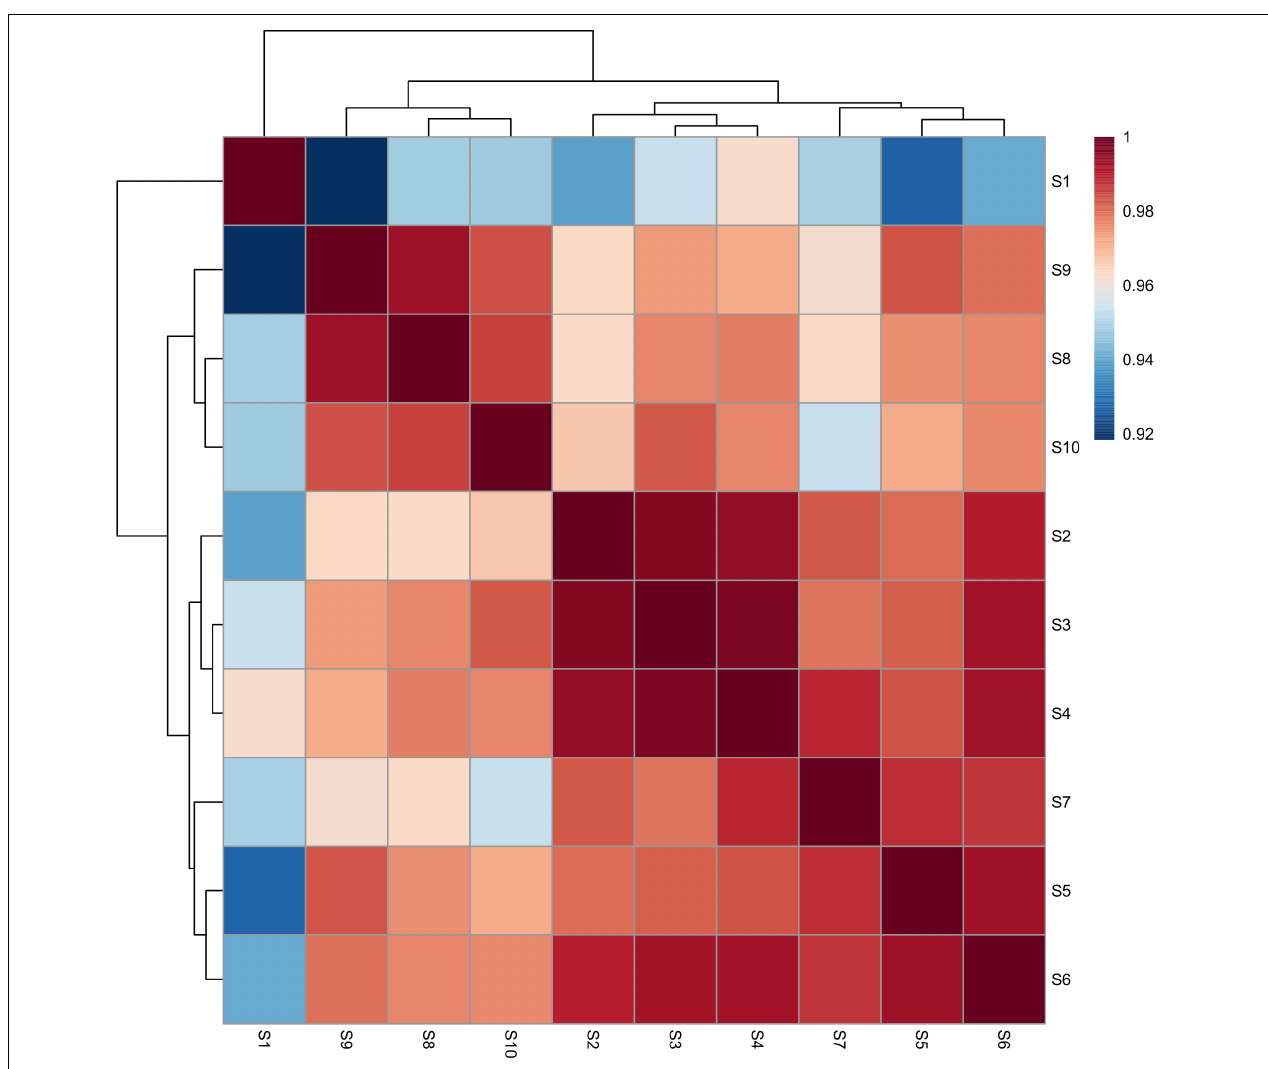
FIGURE 3 | The correlation coefficient for all the S. oblata